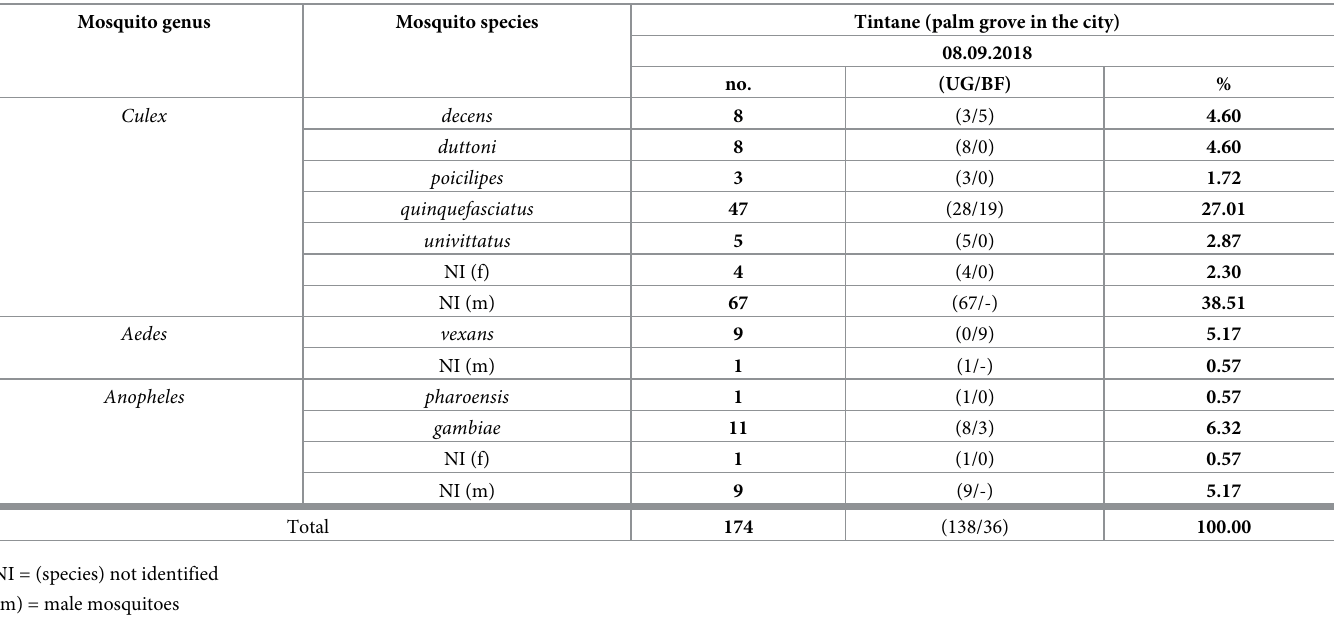
Table 3. Number of collected mosquitoes in Hodh El Gharbi. Mosquito